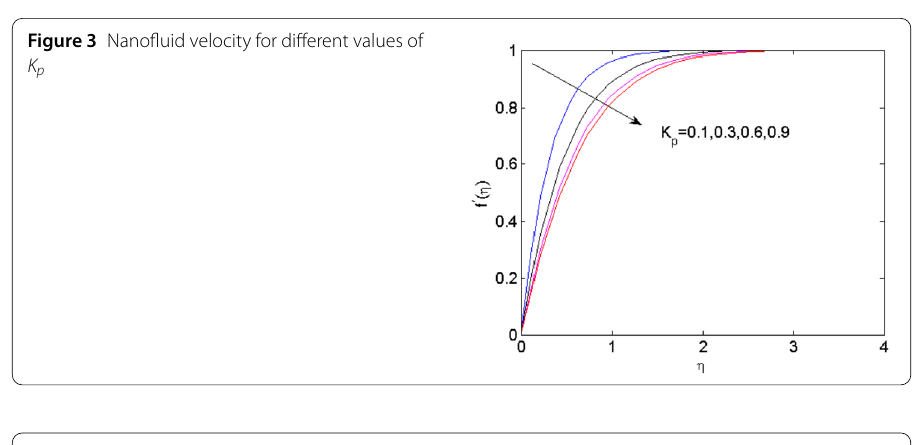
Figure 4 Nanofluid velocity for different values of